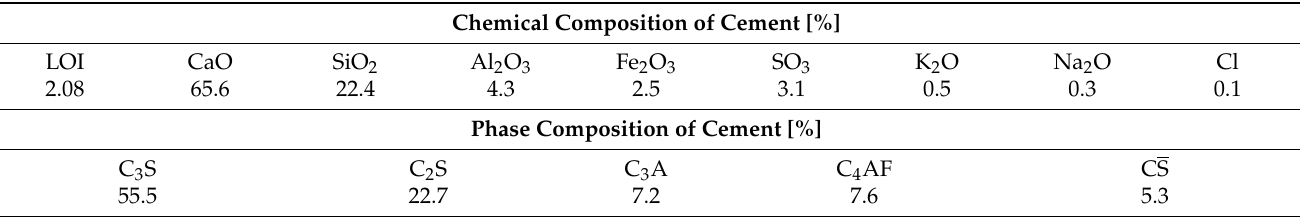
Table 1. Chemical and phase compositions of cement prepared in a laboratory ball mill.